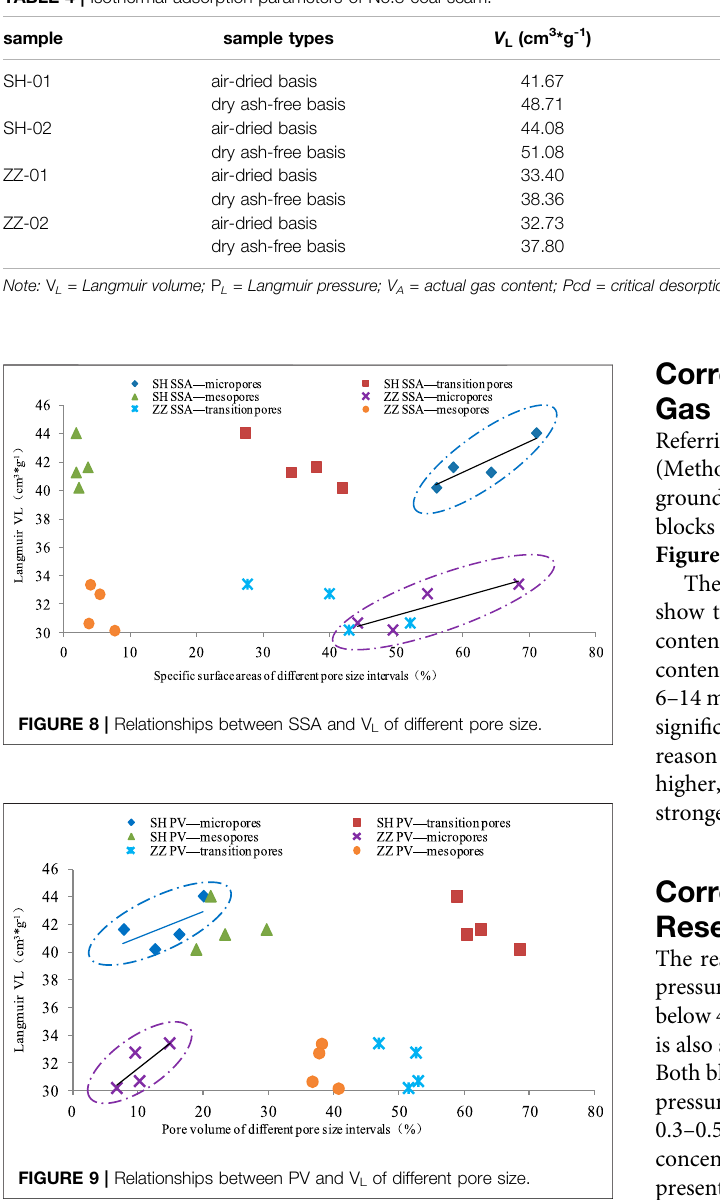
TABLE 4 | Isothermal adsorption parameters of No.3 coal seam.